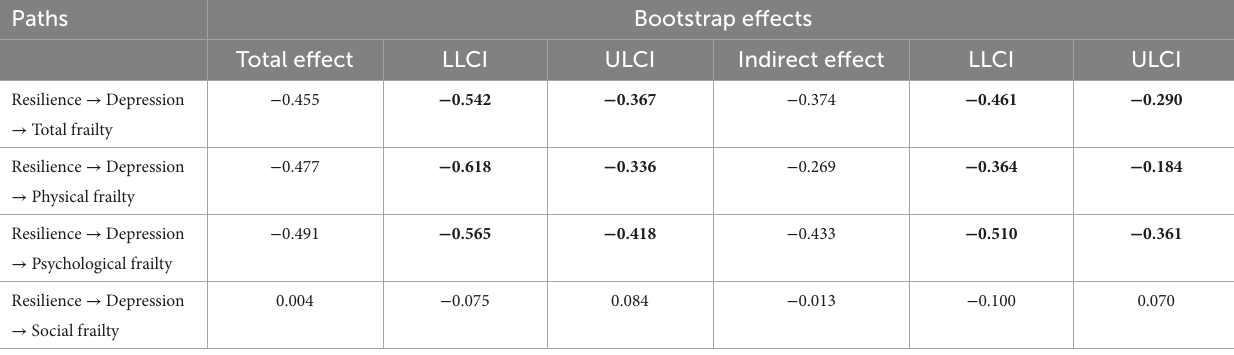
TABLE 3 Results of mediating effect for depression between resilience and